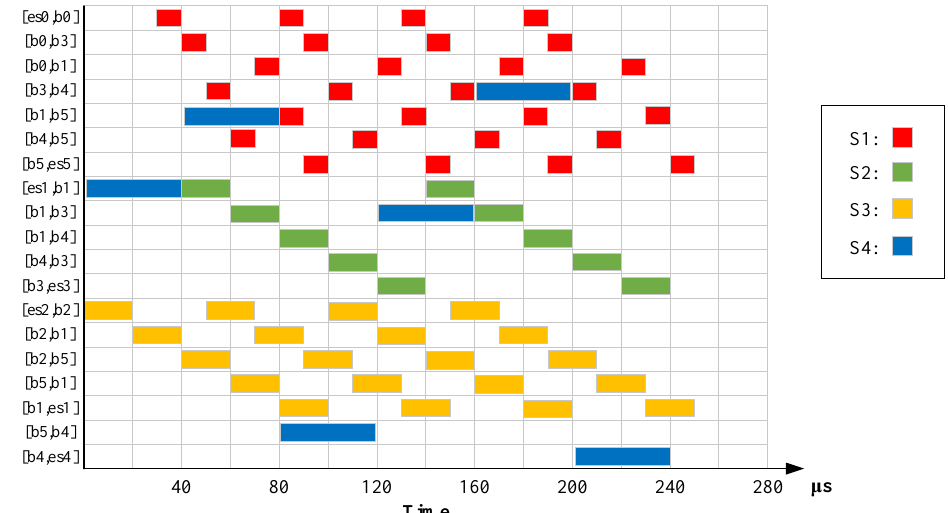
Figure 7. The no-wait schedule result of the illustrative RAMR routing scheme in Figure